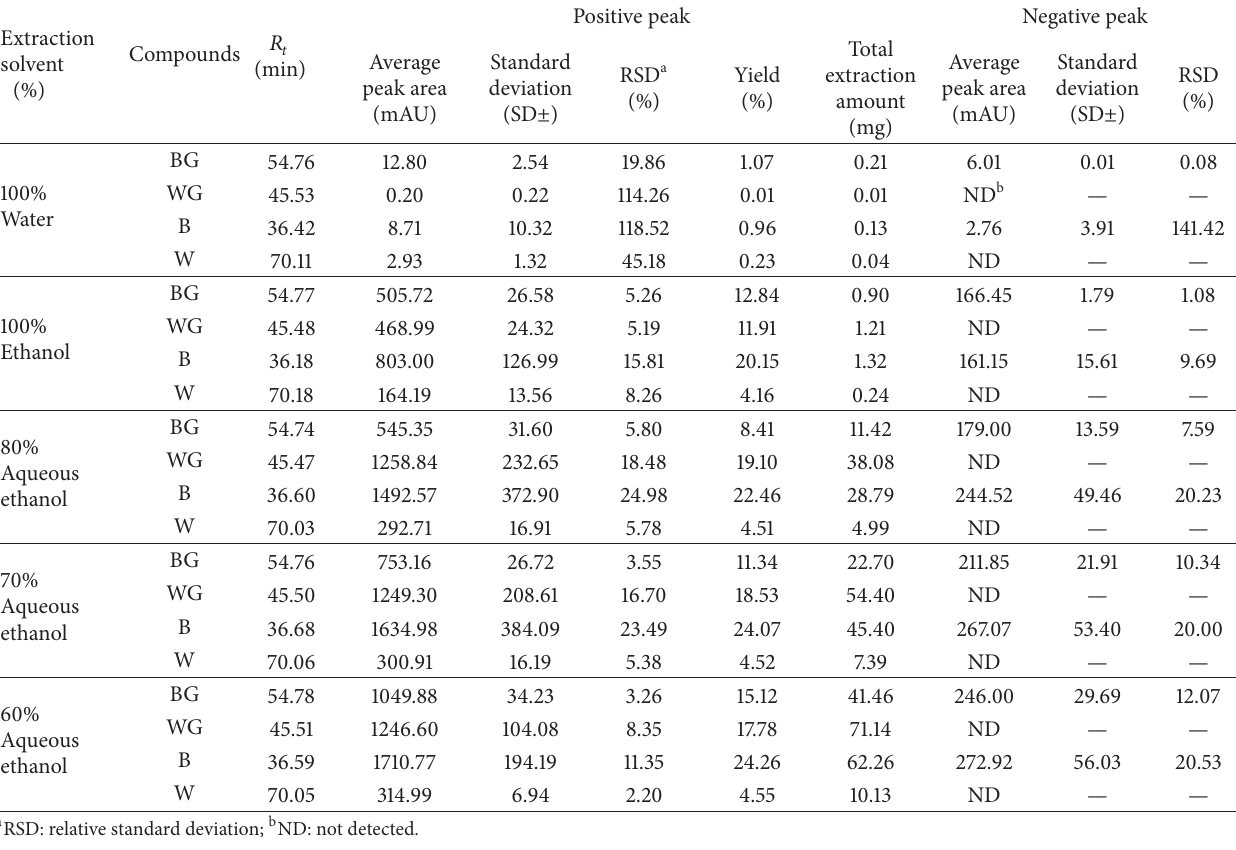
Table 2: Comparison of extracts efficiency by online screening HPLC-ABTS in positive and negative peak area.